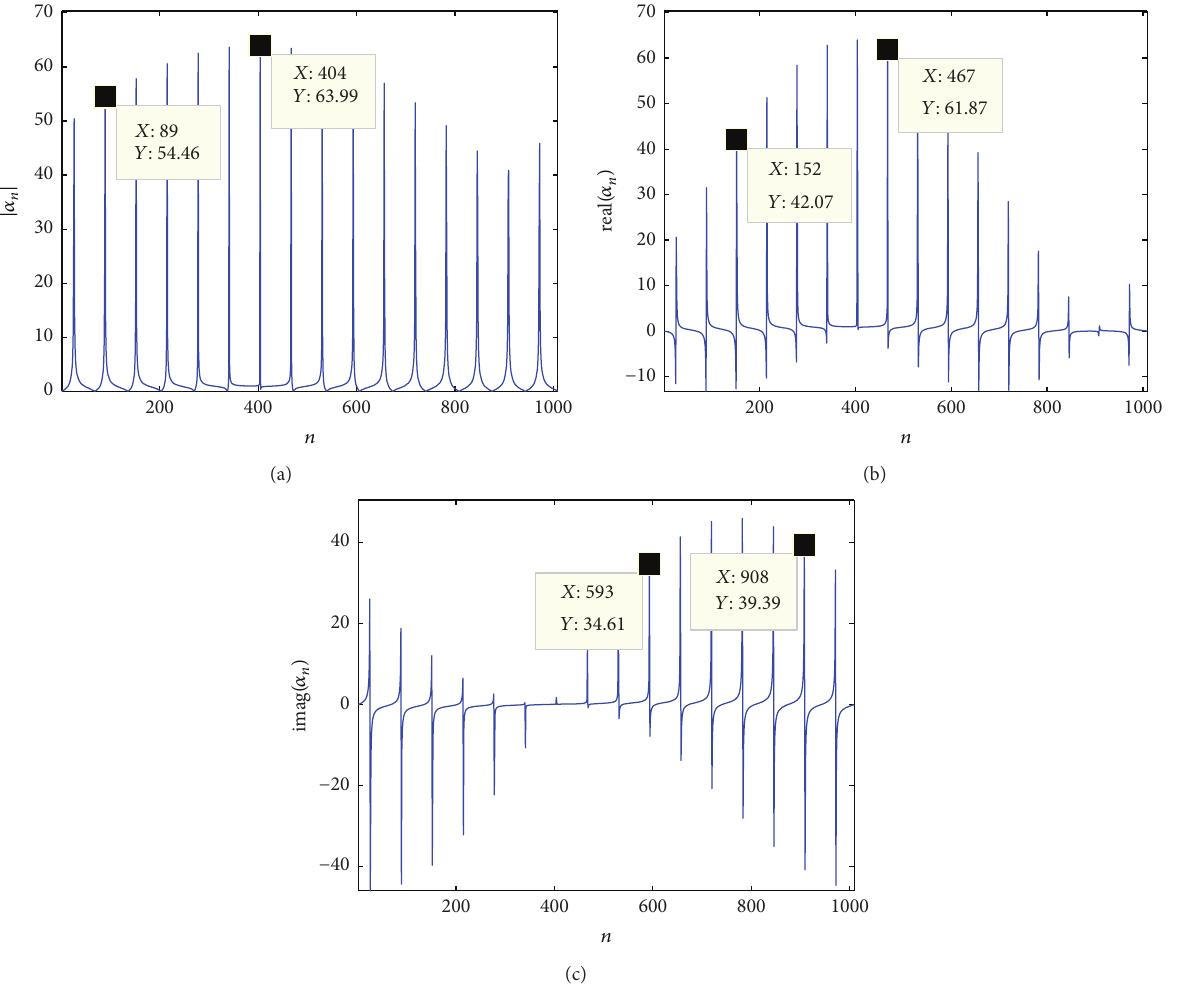
Figure 1: The sparsity of 𝛼 𝑛 when 𝑁 = 1024 , 𝑀 = 64 , 𝑟 = 16 , and 𝑎 = 40 . (a) {|𝛼 𝑛 |} ; (b) { real (𝛼 𝑛 )} ; (c) { imag (𝛼 𝑛 )}